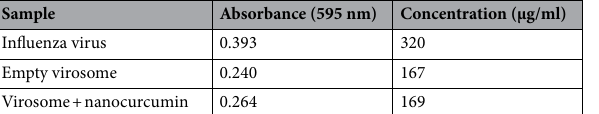
Table 1. Protein concentration and absorbance of the whole virus and virosome